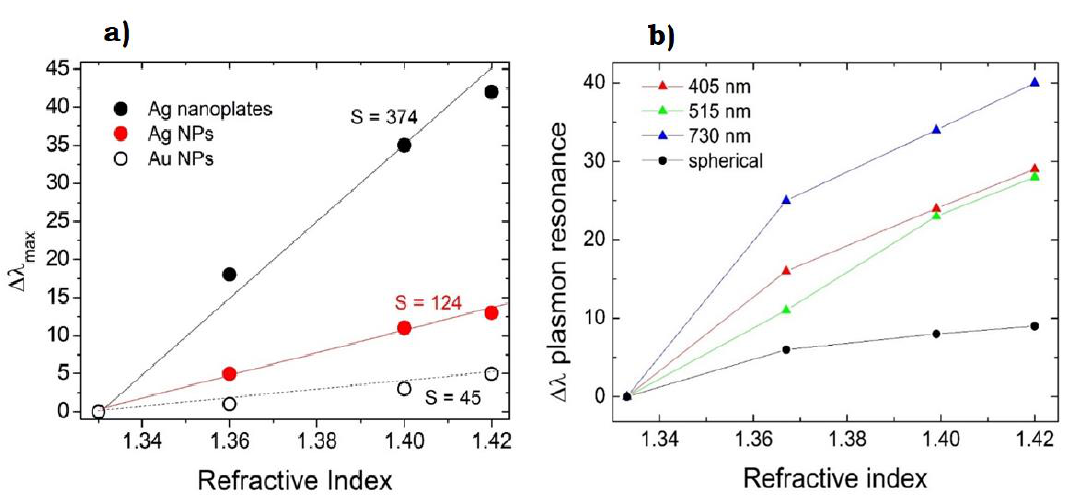
Figure 16. Plasmon sensitivity measurements from gold and silver spherical nanoparticles, obtained by laser ablation in water, and silver triangular nanoplates obtained by white light irradiation of the same spherical NPs ( a ); plasmon sensitivity measurements from triangular NPs obtained from monochromatic light irradiation of spherical NPs (also shown) obtained by laser ablation ( b ). Figure 16a reprinted from Ref. [156], Copyright (2019), with permission from Elsevier. Figure 16b reprinted from Ref. [170], with the permission of The Royal Society of Chemistry.